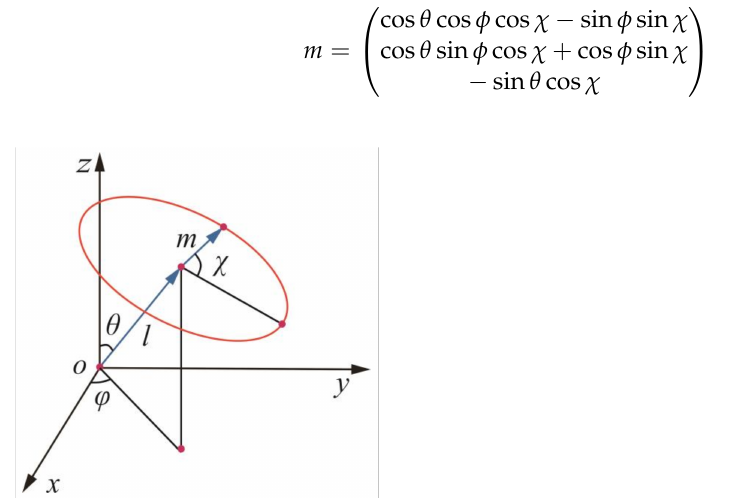
Figure 2. Schematic diagram of each vector l in the lattice space.